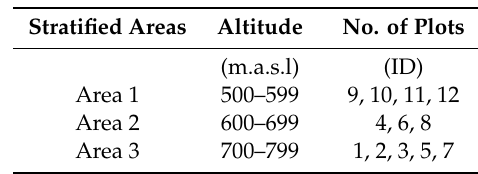
Table 1. Areas stratified according to altitude.